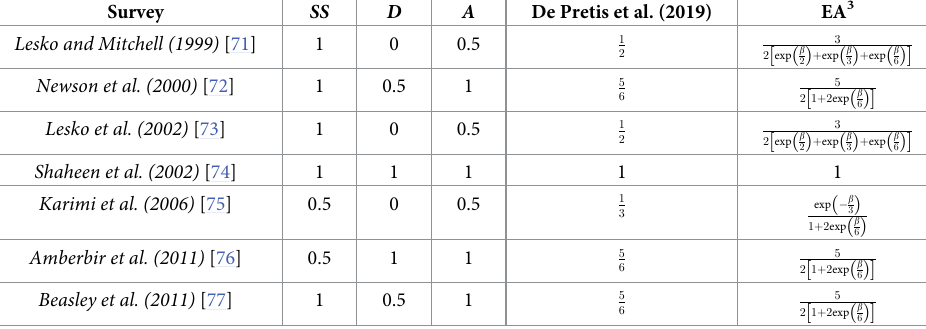
Table 3. Evidence Appraisal Aggregation according to De Pretis et al. (2019) [78] and EA 3 with equally important appraisal dimensions ( ~ R ¼ 1 @3 ) where SS represents the appraised sample size, D the appraised duration and A 3 represents the appraised adjustment and stratification.